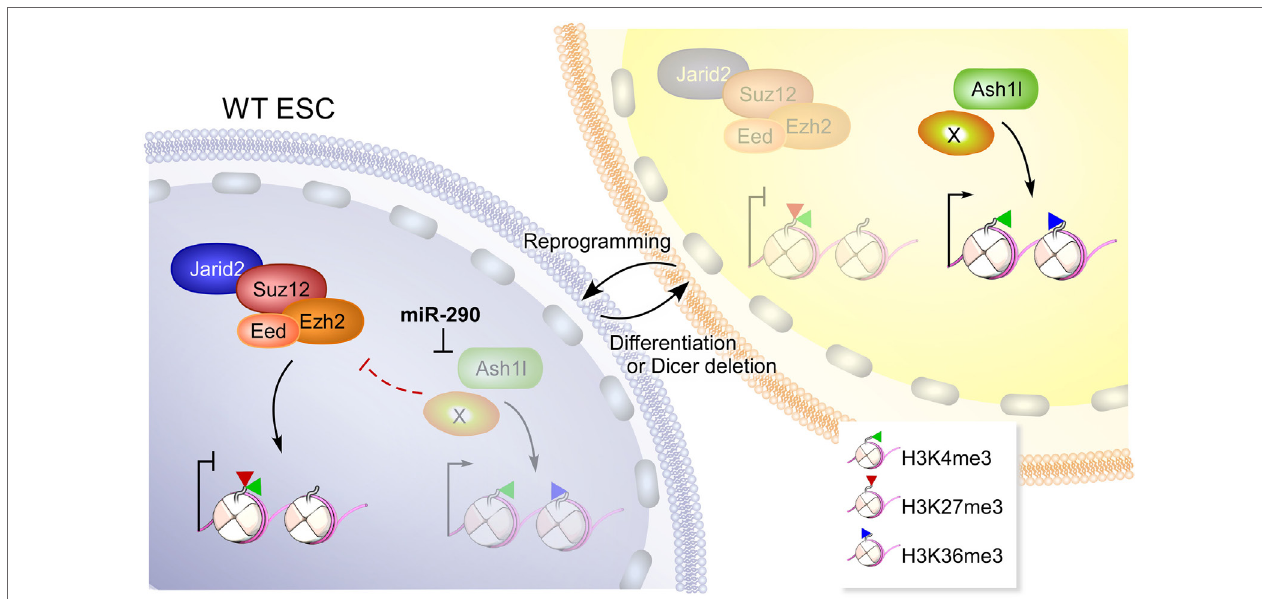
FigURe 2 | A model depicting how miR-290 reprograms the epigenome of embryonic stem cells (ESCs). In wild-type (WT) ESCs, high levels of miR-290 represses Ash1l and perhaps additional targets (depicted by “X”) that can otherwise antagonize polycomb repressive complex 2 (PRC2) (containing Ezh2, Eed, Suz12, and Jarid2). PRC2 activity results in deposition of H3K27me3 marks on chromatin including bivalent domains that harbor H3K4me3 (20), a mark on active or poised promoters. Upon Dicer deletion or differentiation, miR-290 levels are reduced and can no longer repress Ash1l and additional targets. Unfettered, Ash1l activity results in increased H3K36me3 marks and antagonizes PRC2 (17). This figure is reproduced from Kanellopoulou et al.